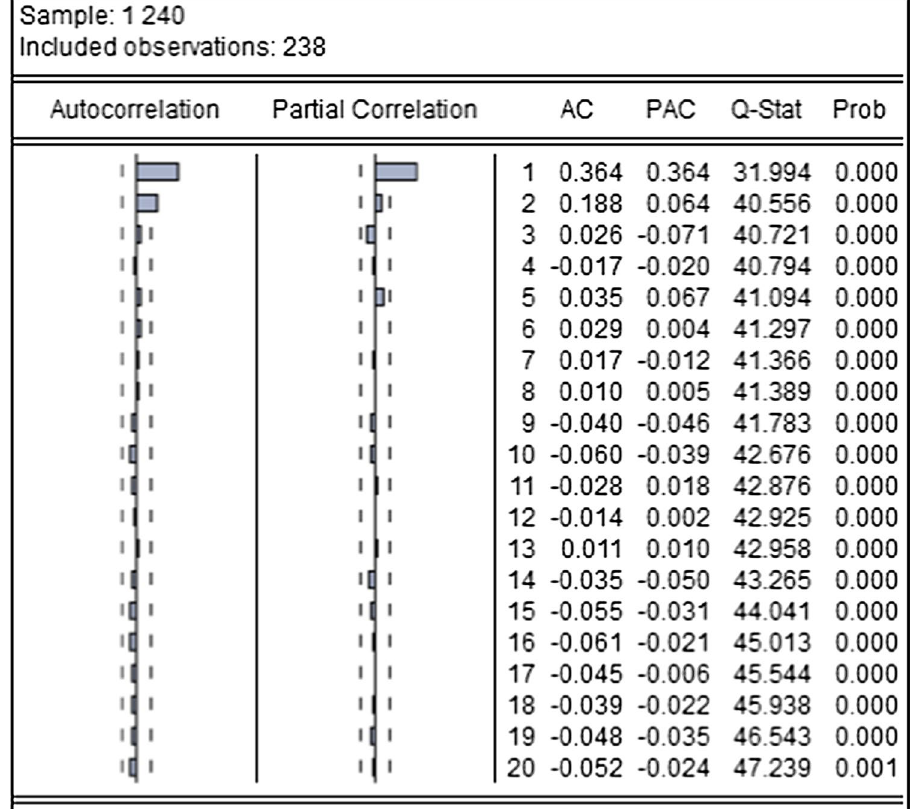
(AC) and partial autocorrelation function (PAC) of the FAO Penman–Monteith residual series with 20